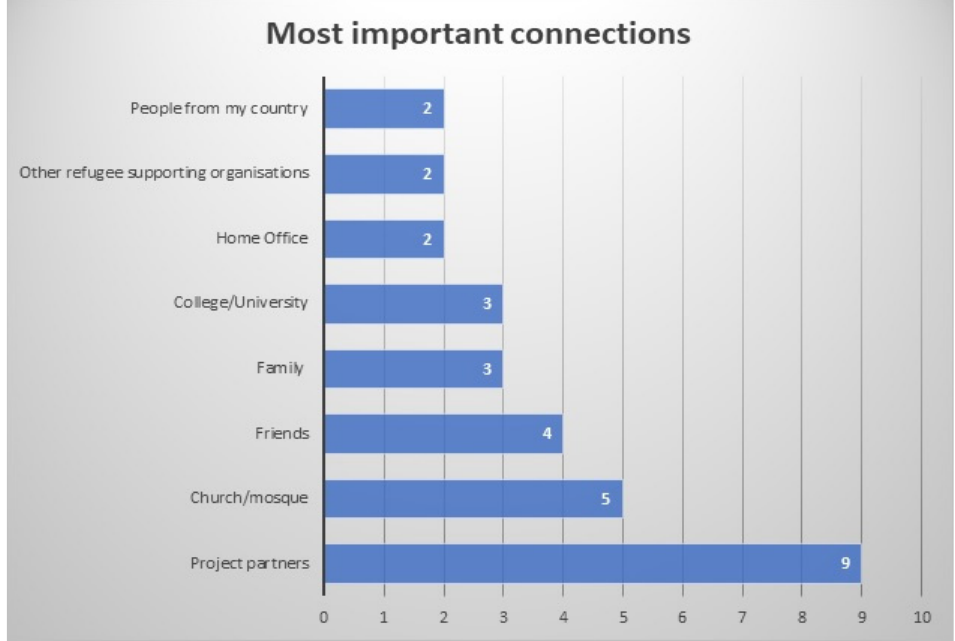
Figure 3. Most important connections based on which connections were specifically stated as being the most important. The figure only includes connections which were mentioned at least twice.